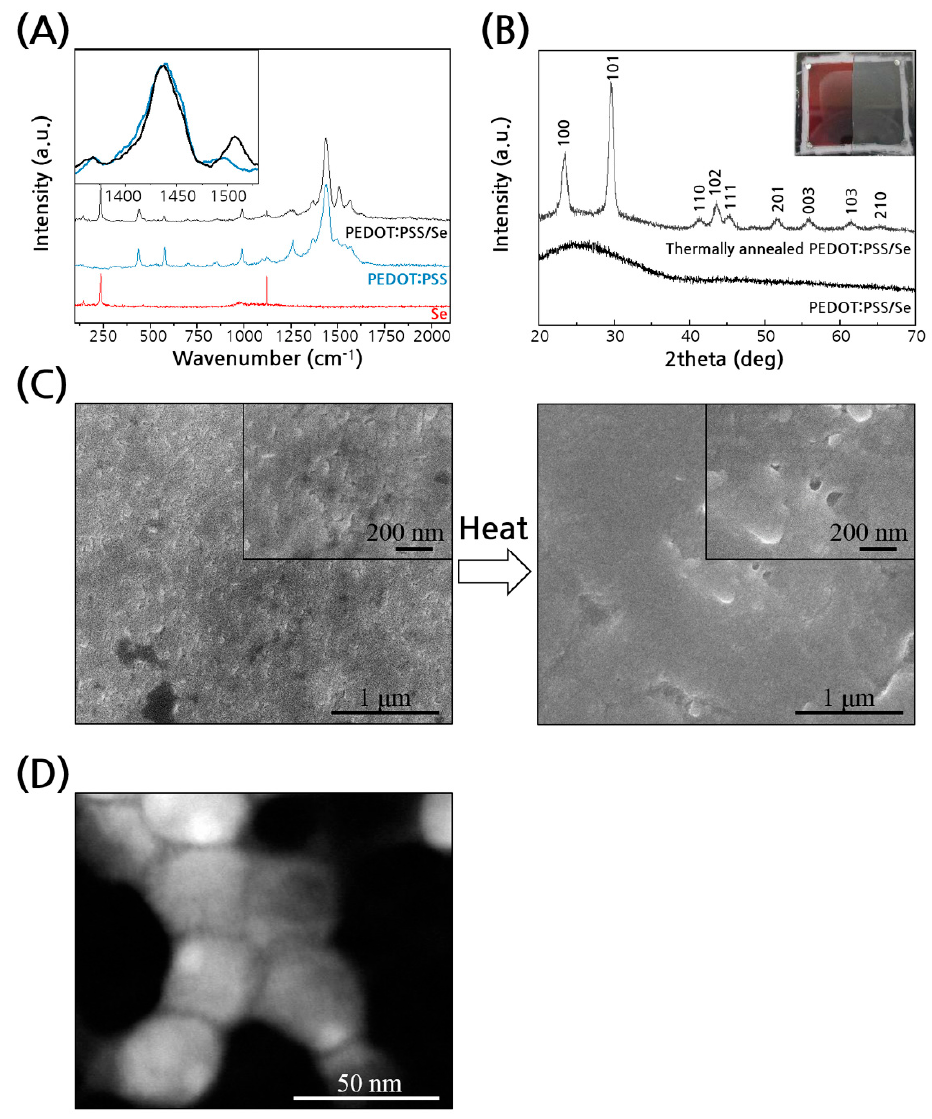
Figure 3. ( A ) Raman scattering spectra of PEDOT:PSS/Se, PEDOT:PSS, and Se. Effects of thermal annealing of the composite films. ( B ) X-ray diffraction (XRD) traces. Inset: photograph of the composite films before (left) and after of thermal annealing (right). ( C ) SEM images of top surfaces of the composite films before (left) and after thermal annealing (right). ( D ) HAADF-STEM image of thermally annealed composites.